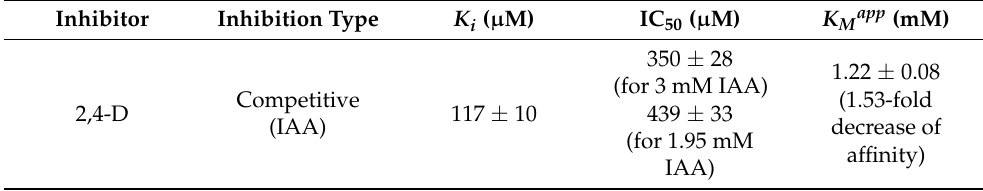
Figure 9. Effect of 2,4-D (2,4-dichlorophenoxyacetic acid) on IAGlc synthase. The assay was per- formed in the presence of 1.95 or 3.0 mM IAA. Inhibition (%) was expressed as the means ± SD for three repetitions. The following concentrations of 2,4-D were used for this assay: 0; 75; 250; 375; 500 and 675 μ M. Enzyme activity was determined using [ 14 C]IAA after TLC. Table 3. Inhibition of IAGlc synthase by 2,4-dichlorophenoxyacetic acid (2,4-D).